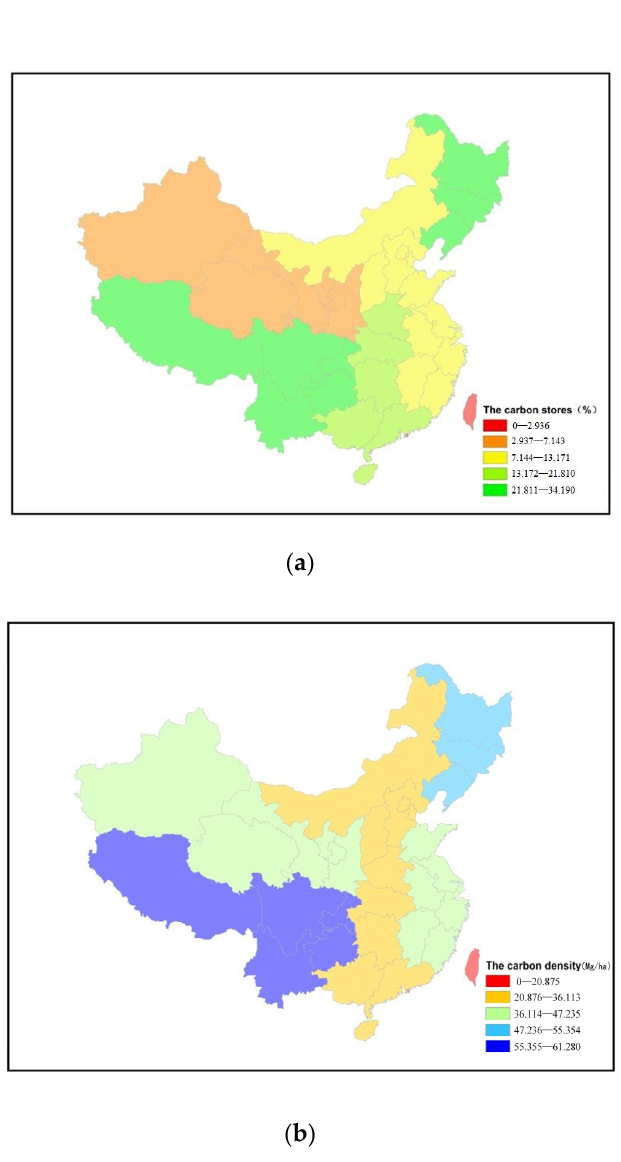
Figure 6. ( a ) Geographical distribution of carbon stores in China’s arboreal forests; ( b ) Geographical distribution of carbon density in China’s arboreal forests.